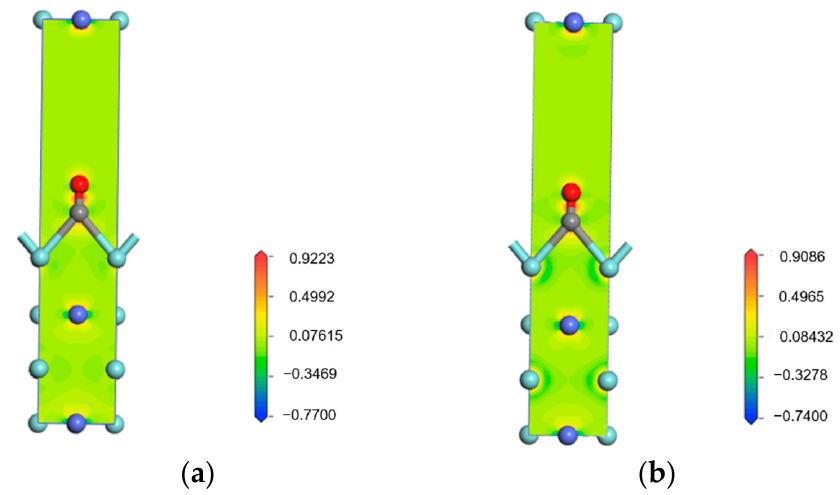
Figure 5. Charge density differences of ( a ) ZrCo and ( b ) Zr 0.8 Ti 0.2 Co.